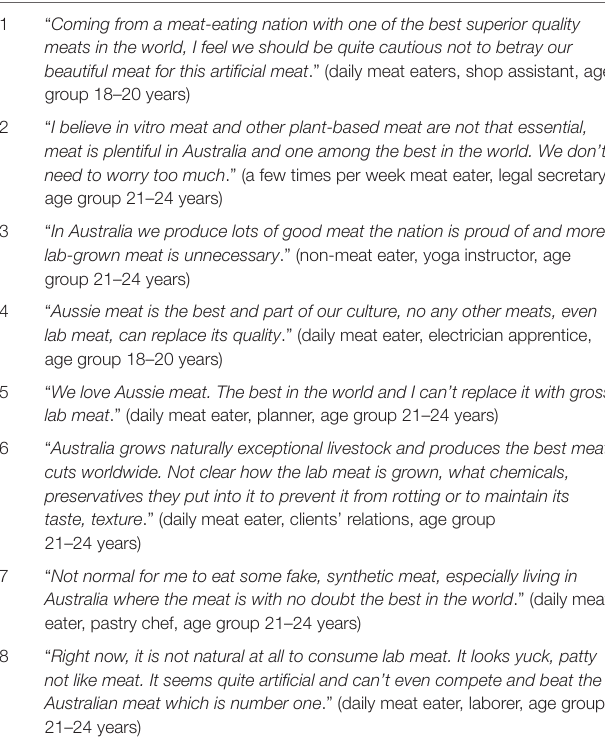
TABLE 7 | Sydney Gen Z’s pride with Australian meat.